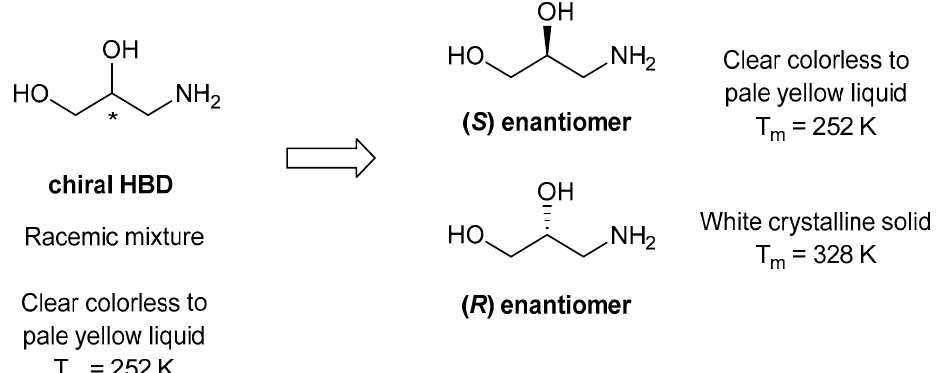
Figure 1. 3-Amino-1,2-propanediol and its chemico-physical properties as an HBD for the novel